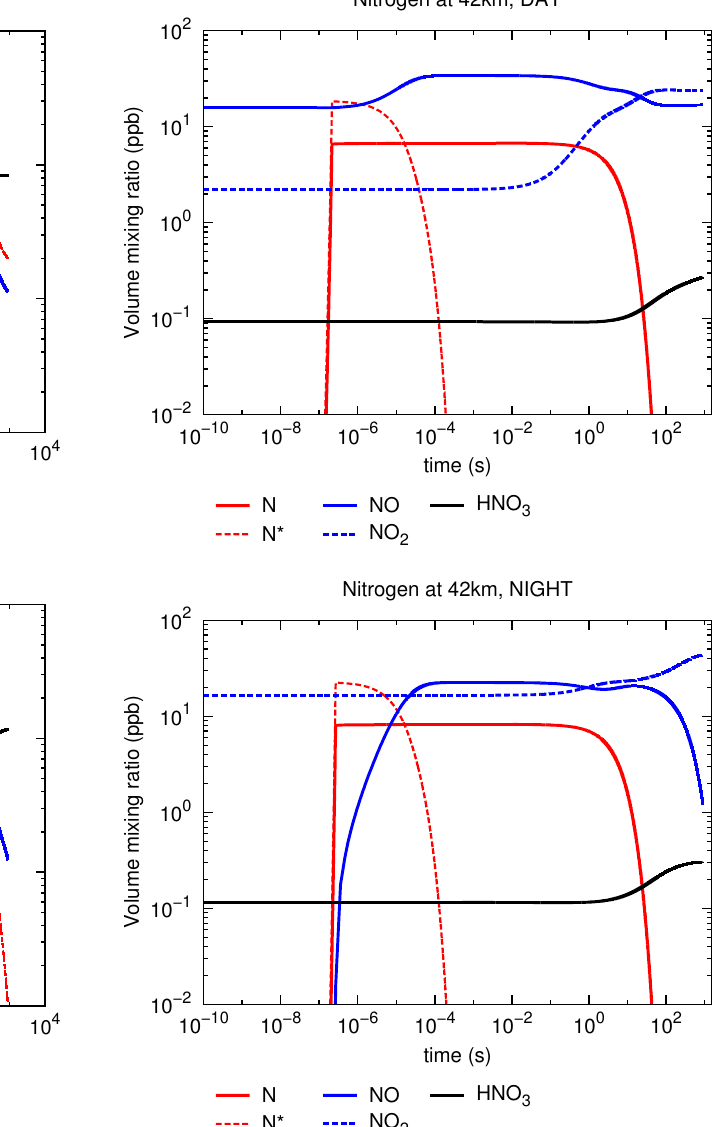
Fig. 5. Modelled evolution of the volume mixing ratios of hydrogen species in a sprite streamer at 42 km altitude. Upper panel: daytime; lower panel: night-time. Fig. 6. Modelled evolution of the volume mixing ratios of nitrogen species in a sprite streamer at 42 km altitude. Upper panel: daytime; lower panel: nighttime.